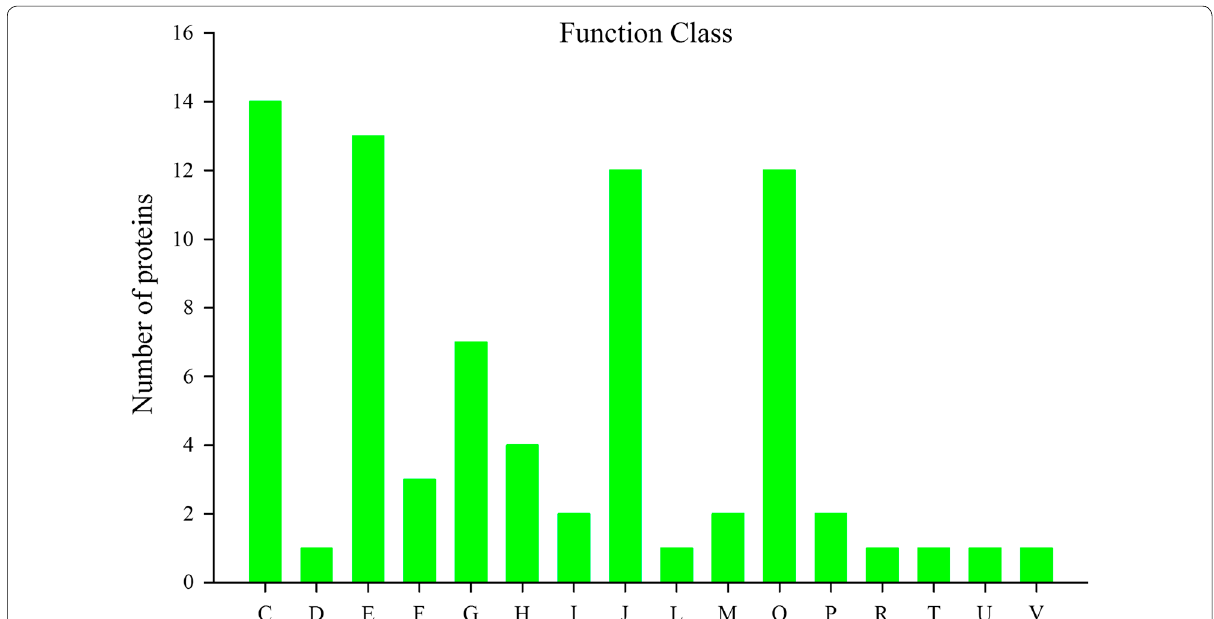
Fig. 5 Functional classification of proteins by COG. C Energy production and conversion. D Cell division and chromosome partitioning. E Amino acid transport and metabolism Coenzyme. F Nucleotide transport and metabolism. G Carbohydrate transport and metabolism. H Coenzyme transport and metabolism. I Lipid transport and metabolism. J Translation, ribosomal structure and biogenesis. L Replication, recombination and repair. M Cell wall/membrane/envelope biogenesis. O Posttranslational modification, protein turnover, chaperones. P Inorganic ion transport and metabolism. R General function prediction only. T Signal transduction mechanisms. U Intracellular trafficking, secretion, and vesicular transport. V Defense mechanisms